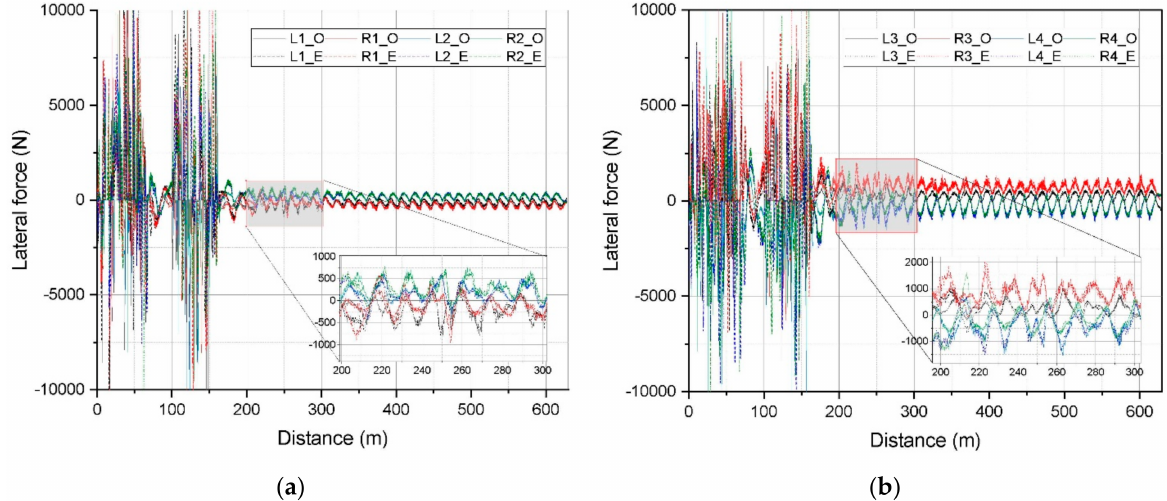
Figure 9. The comparison of lateral forces: ( a ) lateral forces for 1st and 2nd axles; ( b ) lateral forces for 3rd and 4th axles.